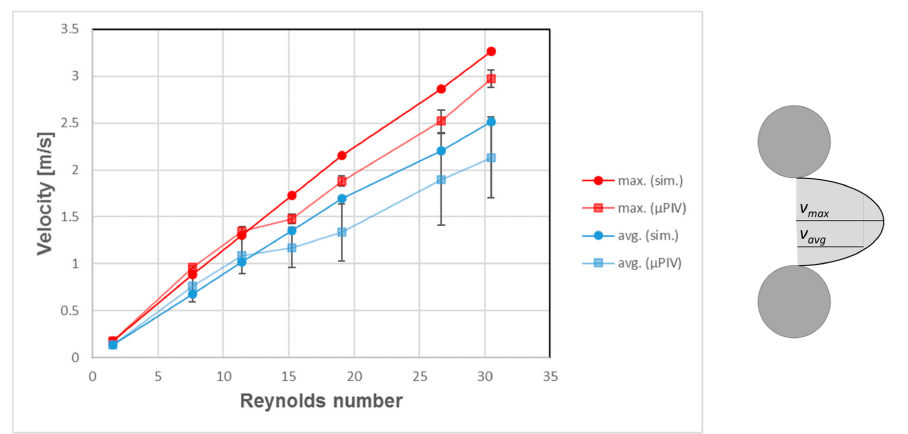
Figure 14. Velocities (maximum and average between posts) depending on Reynolds number at median z layer. The simulation data shows a linear correlation between Reynolds number and both maximum and average velocity. The µ PIV data, however, show that velocities do not continue to grow in proportion at Reynolds numbers higher than